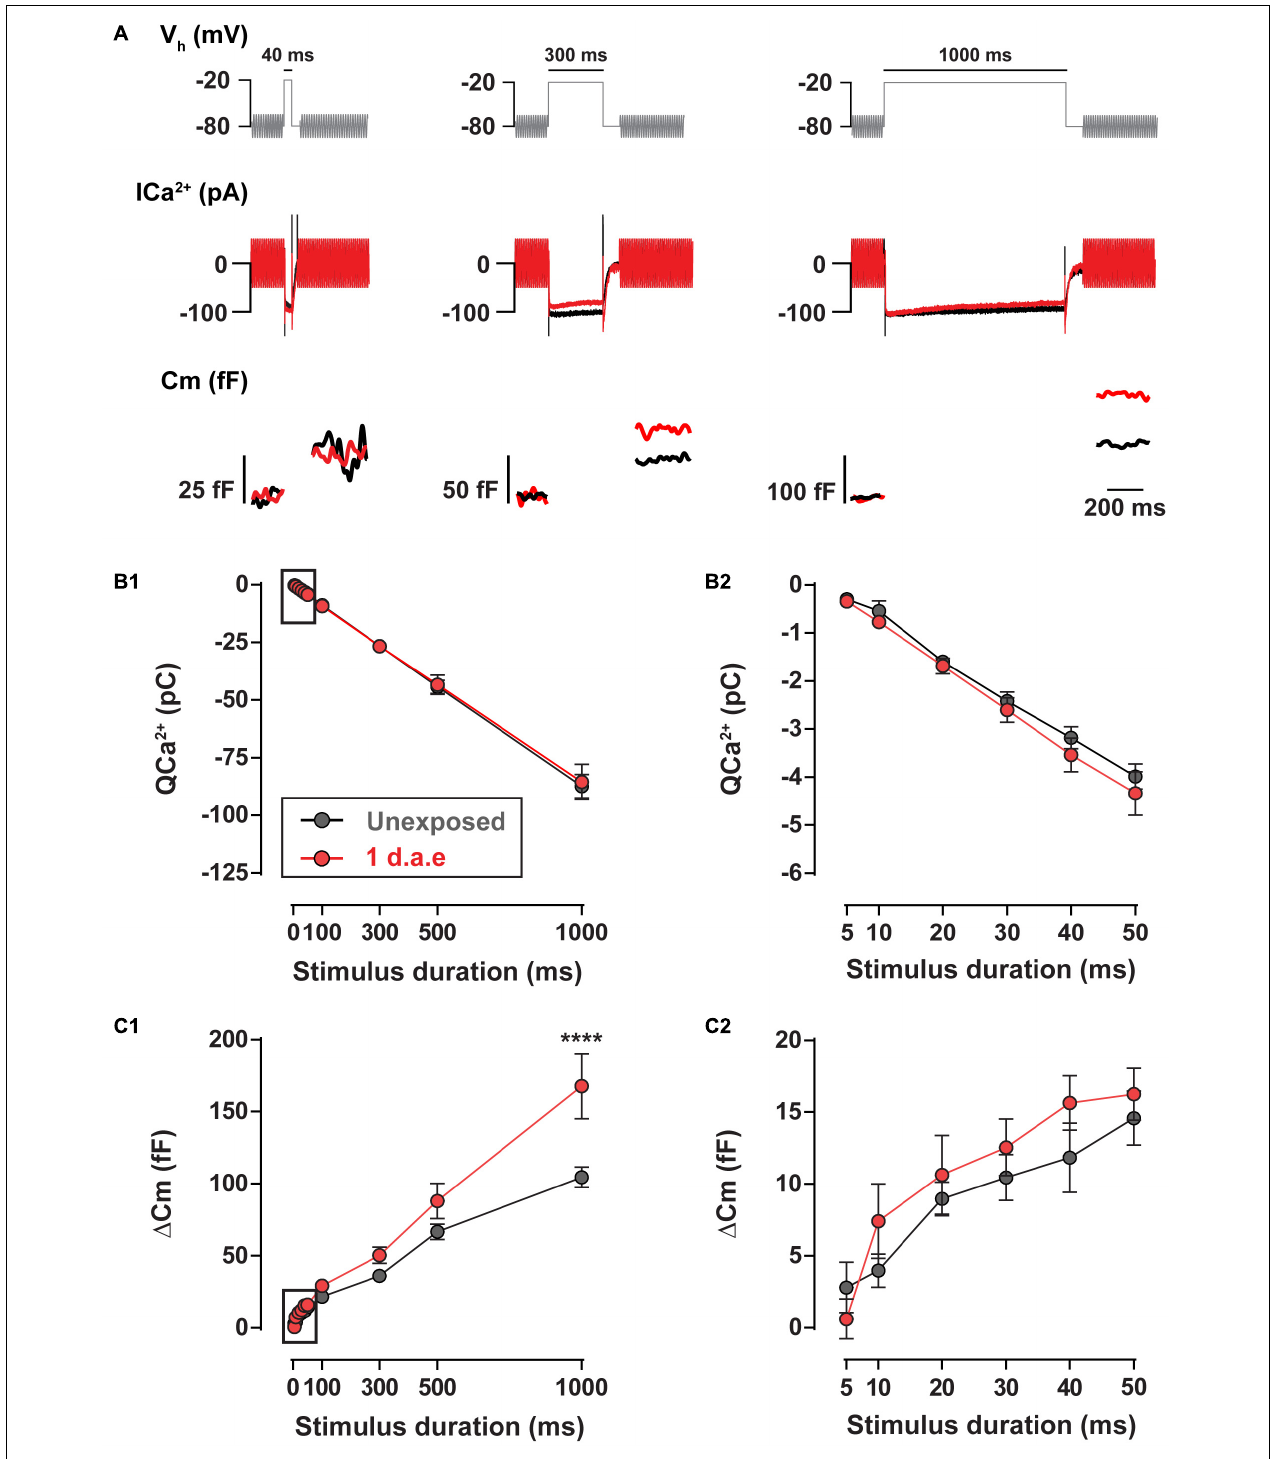
FIGURE 5 | Exocytosis triggered by long pulses is increased 1 d.a.e. to 120 dB noise. (A) Voltage protocol (top), Ca 2 + currents (ICa 2 + ) (middle), and membrane capacitance (Cm) (bottom) traces of representative control (Unexposed, black traces) and 1 d.a.e. (red traces) inner hair cells (IHCs) elicited by − 20 mV test pulses of 40 ms (left panel), 300 ms (middle panel), and 1,000 ms (right panel). (B1,C1) Ca 2 + current integrals (QCa 2 + ) and exocytosis ( (cid:49) Cm) corresponding to − 20 mV pulses of different durations. (B2,C2) Expansion of B1 and C1 depicting the calcium entry and exocytosis triggered by − 20 mV pulses between 5 and 50 ms. Data is presented as mean ± standard error of the mean (SEM). Statistical comparisons were made using Two-way ANOVA followed by Holm-Sidak multiple comparisons test. **** p < 0.0001.